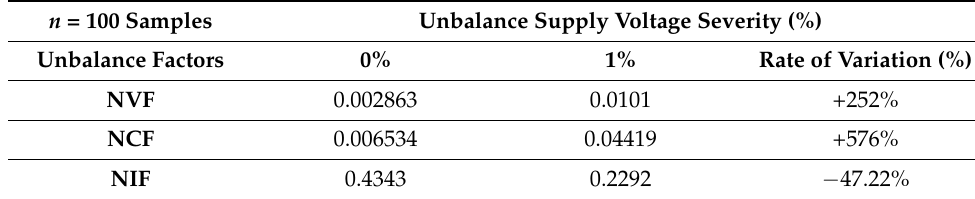
Figure 6. The estimated unbalance factors with an USV of 1.45%. Table 2. Effect of the USV on the defined unbalance